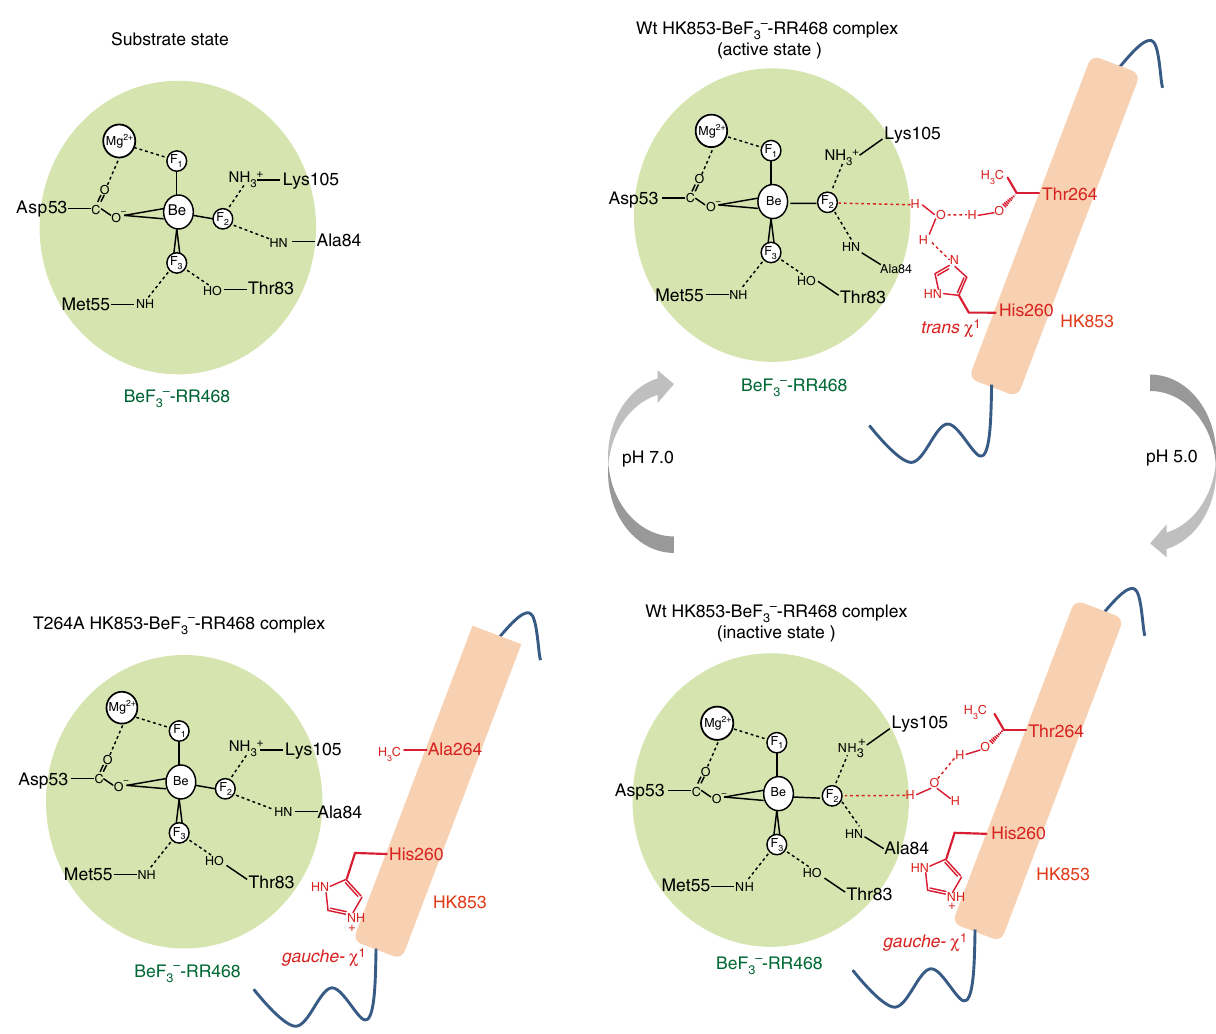
Fig. 3 Proposed role of the conserved HxxxT motif in the pH-gated phosphatase activity of HisKA. Residues in the active site of RR468 and HK853 are shown in black and red, respectively. In the proposed model, the substrate state (upper left) de fi nes the apo state fl uorine chemical shifts, which re fl ects a lack of speci fi c interactions of the F 2 fl uorine atom with HK853. In the catalytically active state (F ca state, upper right), the F 2 fl uorine atom (mimicking an oxygen atom of the phosphate group) forms a hydrogen bond with the catalytic water molecule, which is activated by T264 and H260 of HK853, with H260 in the trans χ 1 rotameric conformation poised for the catalytic attack of the phosphorus atom of phosphorylated D53 (mimicked by BeF 3 − -D53) of RR468. Under acidic conditions, the protonated H260 swings away from the catalytic water molecule, leaving HK853 T264 as the only remaining residue interacting with the catalytic water molecule and the F 2 fl uorine atom of BeF 3 – -RR468, and re fl ecting a catalytically inactive state of HK853 (F ci , lower right). The F 2 atom of BeF 3 - -D53 in the T264A complex shows a similar chemical environment to the F 2 apo state despite the formation of the T264A HK853-BeF 3 - -RR468 complex, consistent with the loss of the F 2 -interacting catalytic water molecule due to the change of H260 χ 1 rotameric conformation to gauche- and the elimination of the side chain hydroxyl group from the T264A mutation (lower